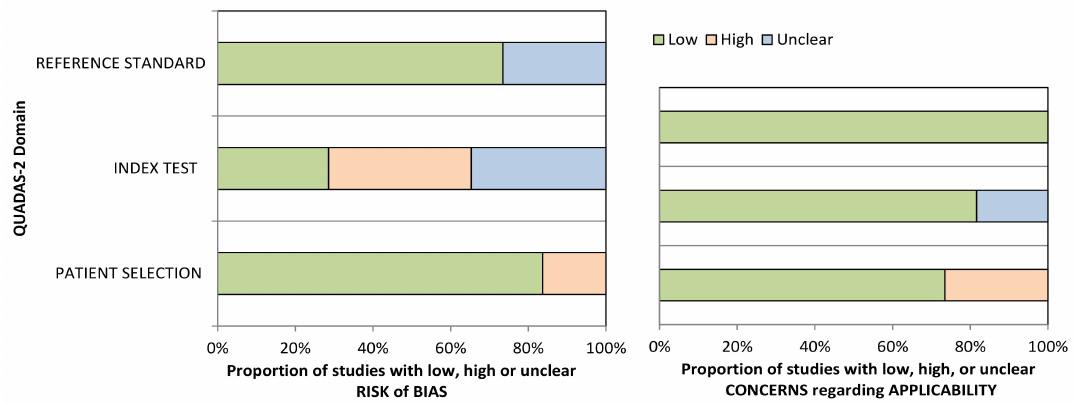
Figure 2. Graphical representation of the overall quality of the selected